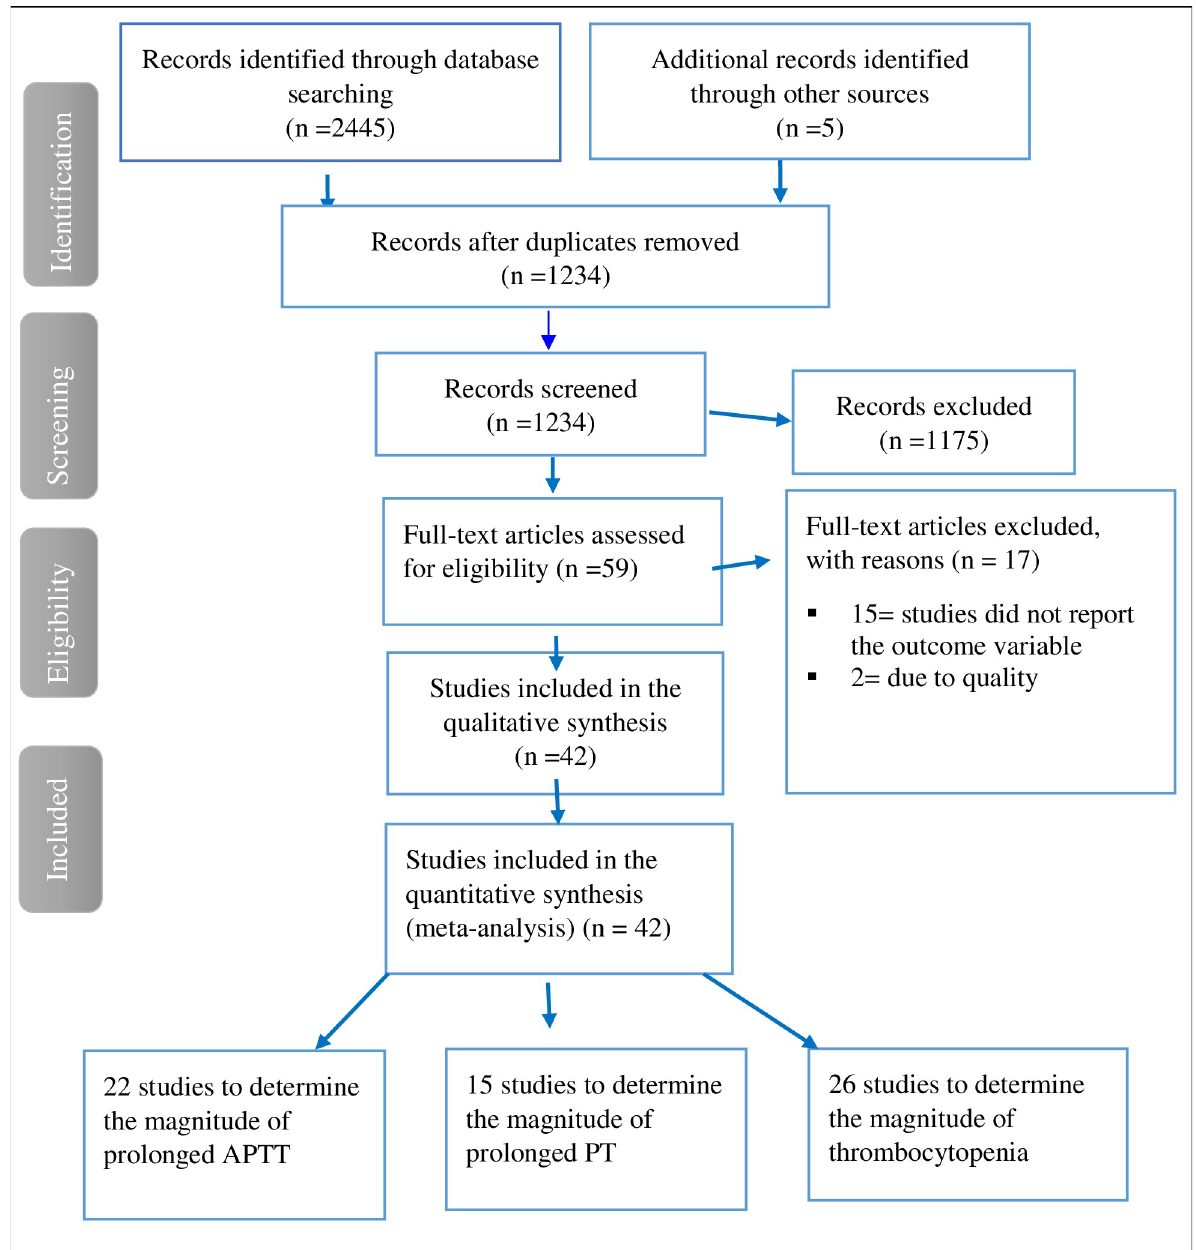
Fig 1. Flow chart to describe the selection of studies for the systematic review and meta-analysis on the magnitude of coagulation abnormalities among dengue fever